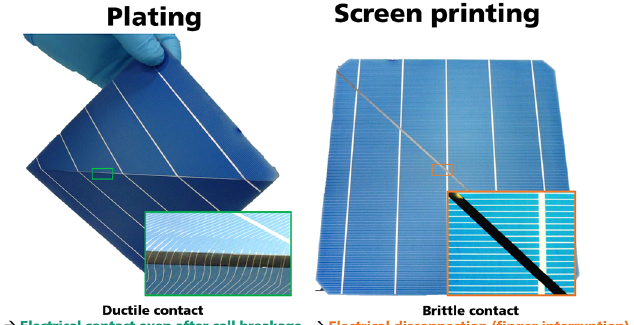
Fig. 7. Photographs of plated and screen-printed bifacial TOPCon solar cells after cell breakage with intact plating fi ngers (ductile) and electrically disconnected screen printing fi ngers